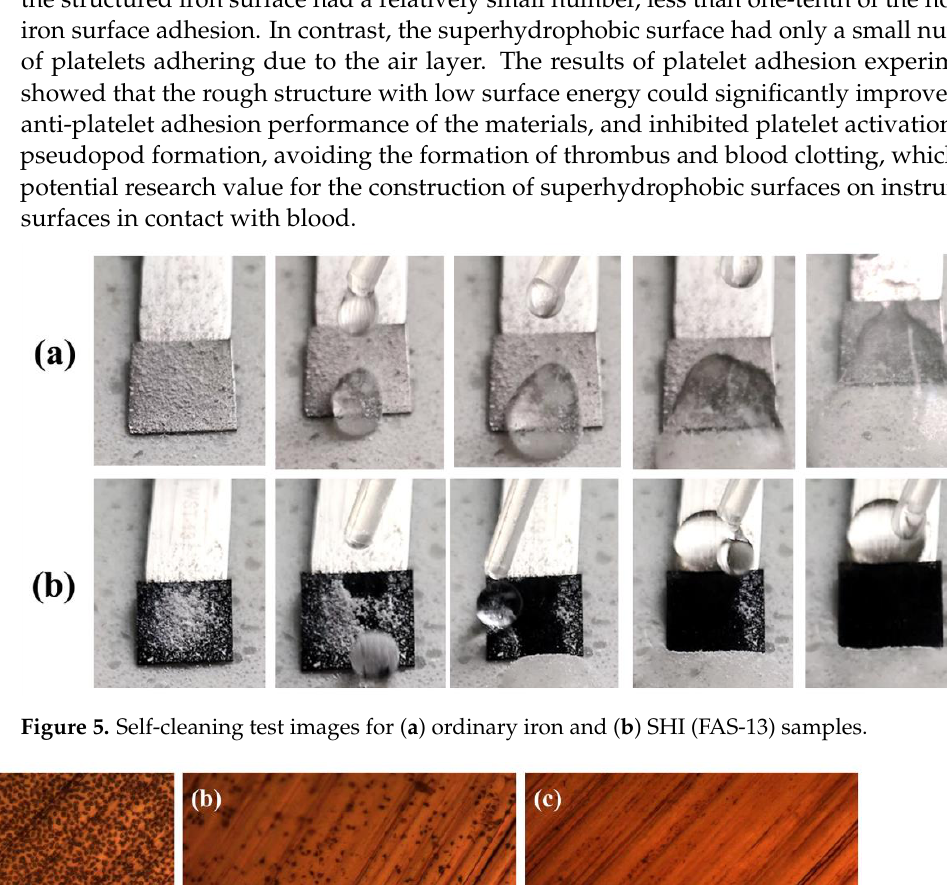
Figure 5. Self-cleaning test images for ( a ) ordinary iron and ( b ) SHI (FAS-13) samples.